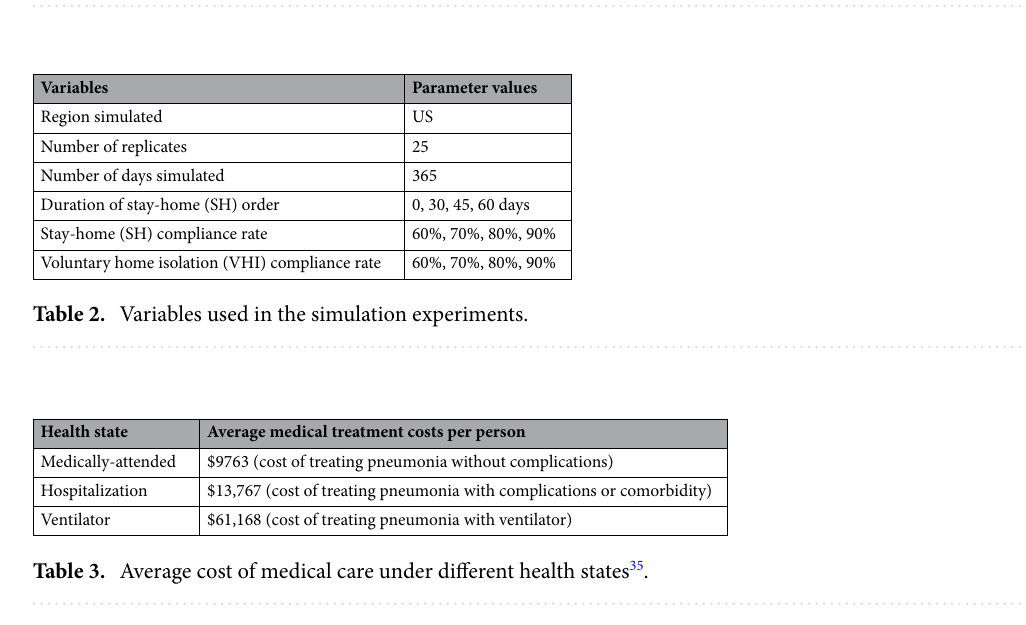
Table 1. Terminology of counterfactual scenarios: VHI and SH refer to “voluntary home isolation” and “stay-home” order respectively. VHI and SH compliance rates can vary between 60 and 90% and the duration of SH order can be 30, 45 or 60 days. The first two numbers in the scenario name indicate compliance rate and the last one indicates the duration of the stay-home order.